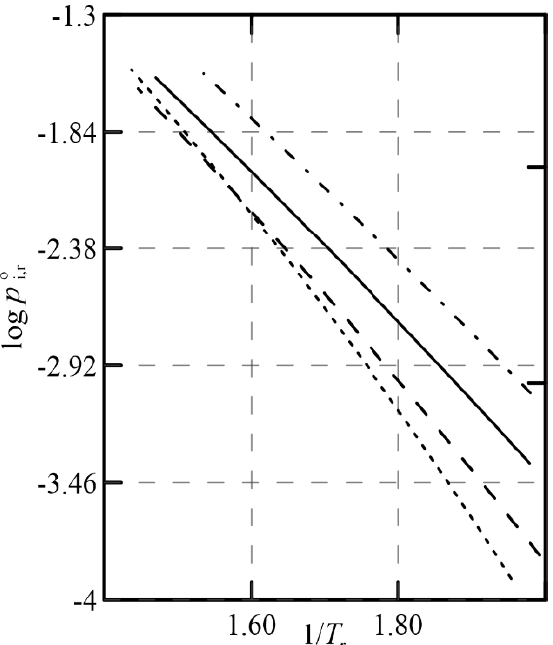
Figure 12. Plot of vapor pressure of the compounds: cyclohexanone ( −−−− ); cyclo- hexanol ( • • • ); 2-methylcyclohexanone ( − · − ); 2-cyclohexen-1-ol (– – –), in reduced coordinates.